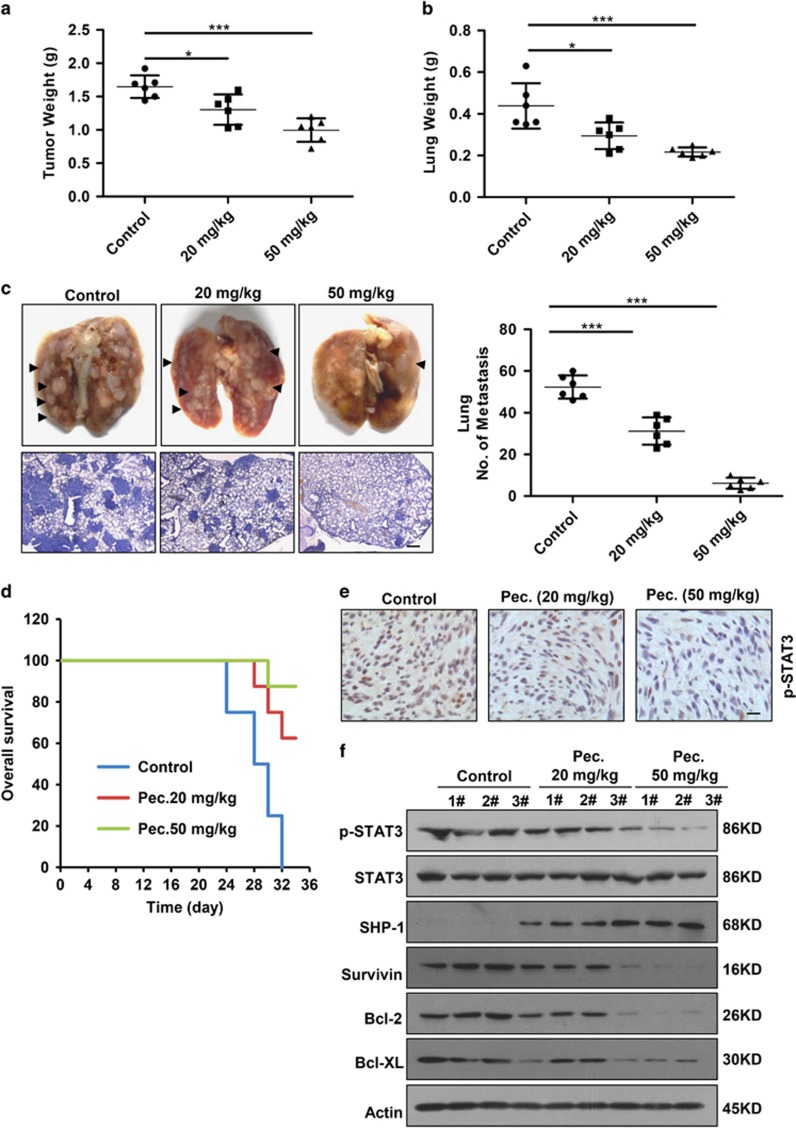
Pectolinarigenin inhibits tumor growth, metastasis and prolongs survival in an orthotopic osteosarcoma mouse model. (a) 143B cells were injected into the medullary cavity of tibia of the tested mice. Twenty-four days after pectolinarigenin administration, mice in different groups were killed and the posterior limb with tumors was weighed (*P<0.05; ***P<0.001). (b) Lungs in different groups were excised and weighed (*P<0.05; ***P<0.001). (c) Lung colonization was visualized by a dissecting microscope and lung metastasis nodules were counted manually (***P<0.001). In all, 4 μm sections of lungs were subject to H&E staining (left lower panel). Scale bar, 100 μm. (d) Overall survival rate in the orthotopic osteosarcoma mouse model. (e) Primary tumors were removed, fixed and paraffin embedded at the end of the experiment. Four micrometer (4 μm) sections were analyzed by IHC using an anti-phospho-STAT3 (Y705) antibody. Scale bar, 100 μm. (f) Primary tumors were lysed and subjected to immunoblotting with indicated antibodies. Actin was used as a loading control